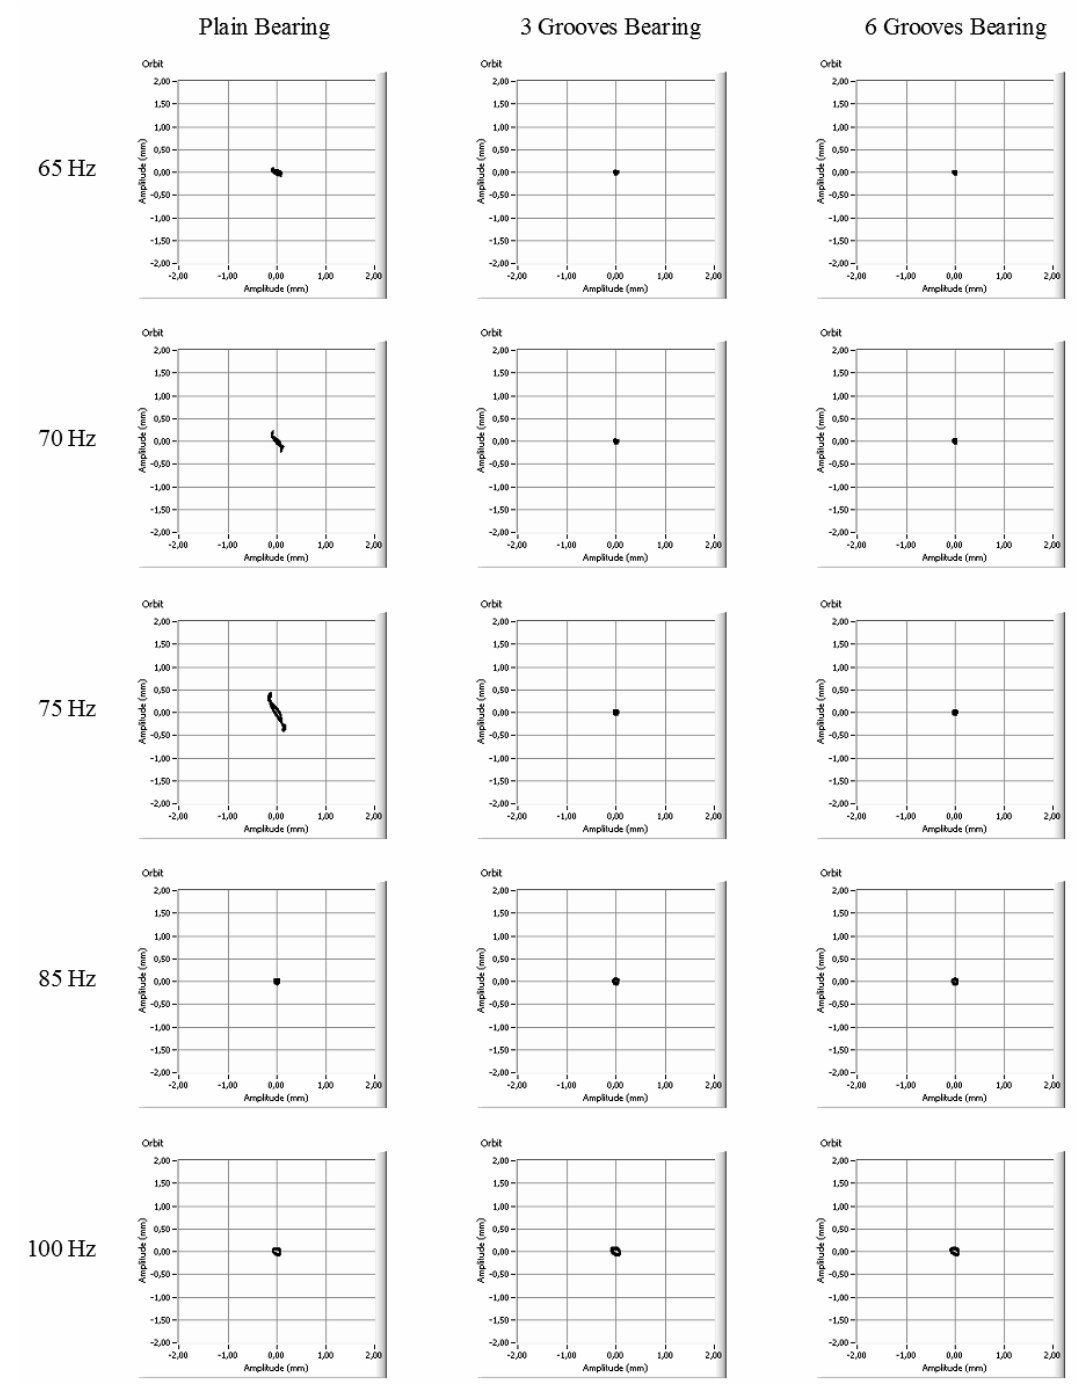
Fig. 10. Results – Orbit